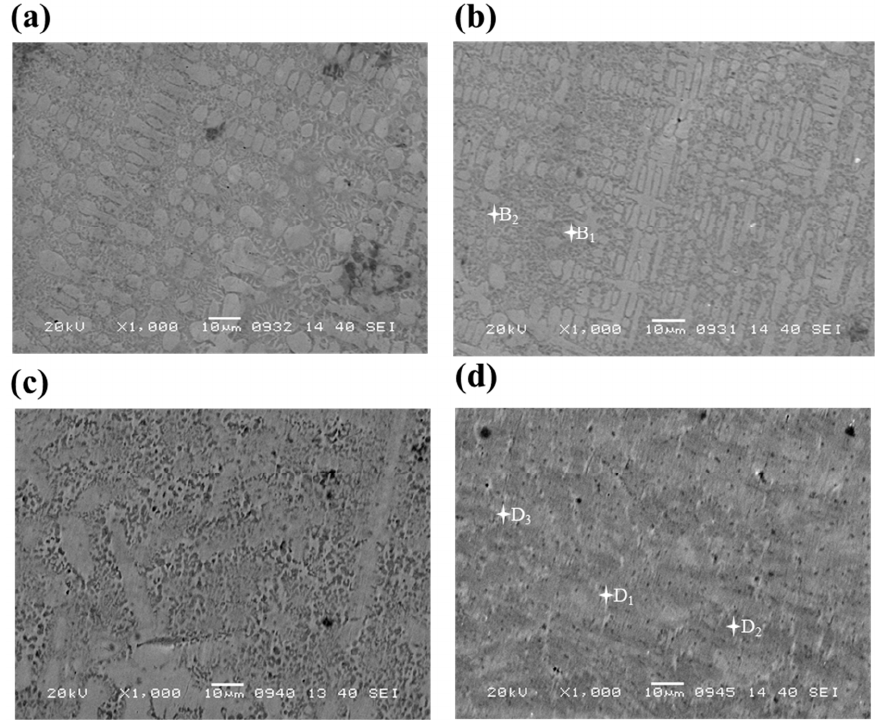
Figure 7. Cross-section SEM morphologies of the middle and surface of the coatings: ( a ) Middle region of L1, ( b ) Surface region of L1, ( c ) Middle region of L3, ( d ) Surface region of L3.